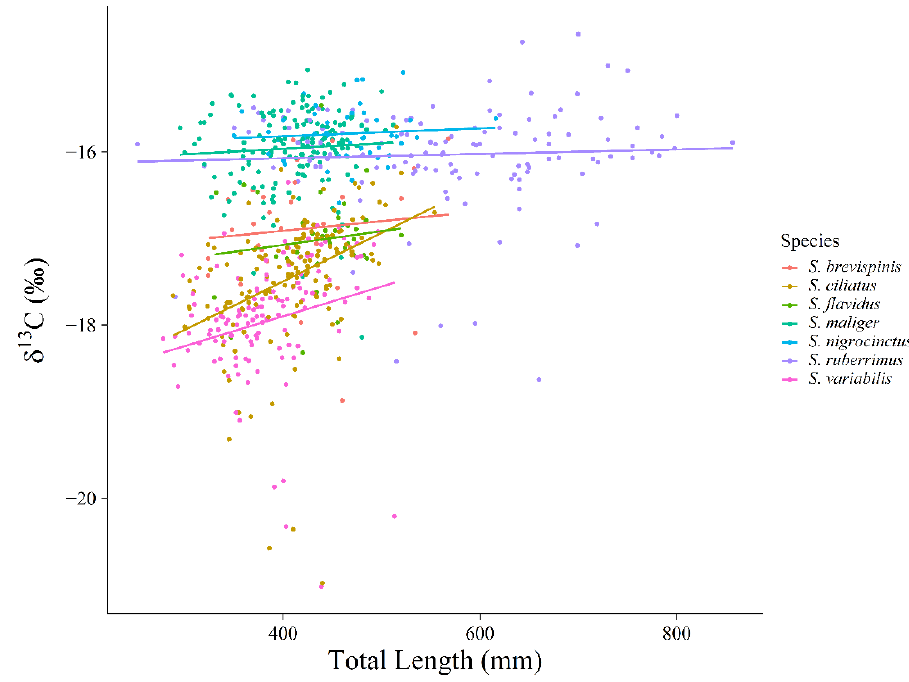
Figure 8. Ontogenetic shifts in δ 13 C by total length for seven rockfish species in this assemblage.